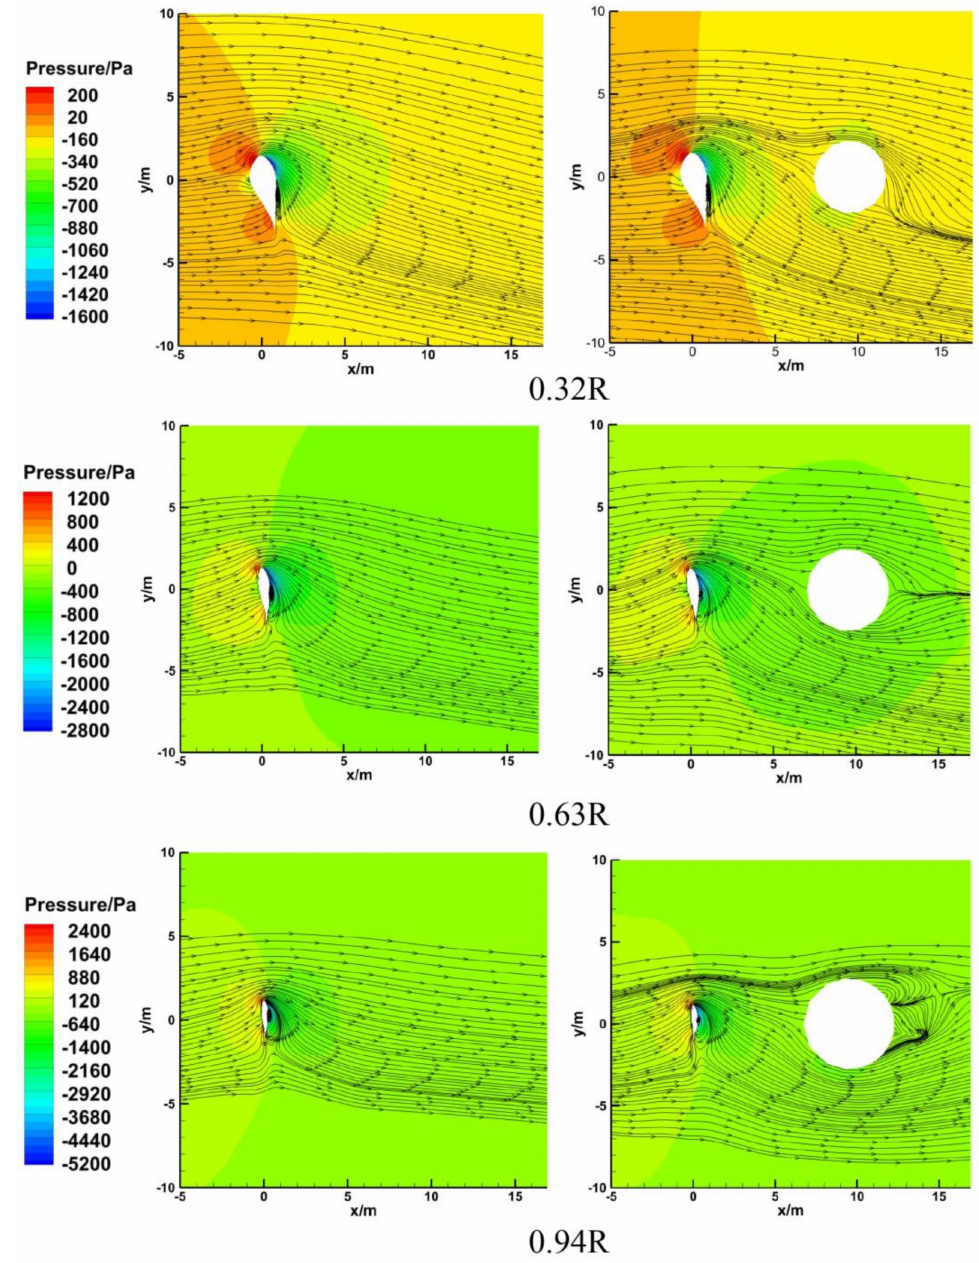
Figure 11. Streamline and pressure contours on different blade sections under surge motion. Meanwhile, the streamline change of the wind turbine with the tower is not obvious compared with the wind turbine without the tower under surge motion, and the main change is concentrated in the wake of the tower. In the 0.32 R section, the streamline behind the tower shifts greatly, and the tower shadow effect is the most obvious in the interference of the flow field. In the 0.63 R section, the streamline on both sides of the tower shifts, and the flow field in this section is affected by both the tower shadow effect and the enhanced blade rotation effect. In the 0.94 R section, there is an obvious stall separation in the flow field behind the tower, and the separation point shifts to the direction of blade rotation. The area near the root of the blade is the main area affected by the tower shadow effect under surge motion, and the effect of the tower shadow effect weakens on the near wake flow field with the increase of blade